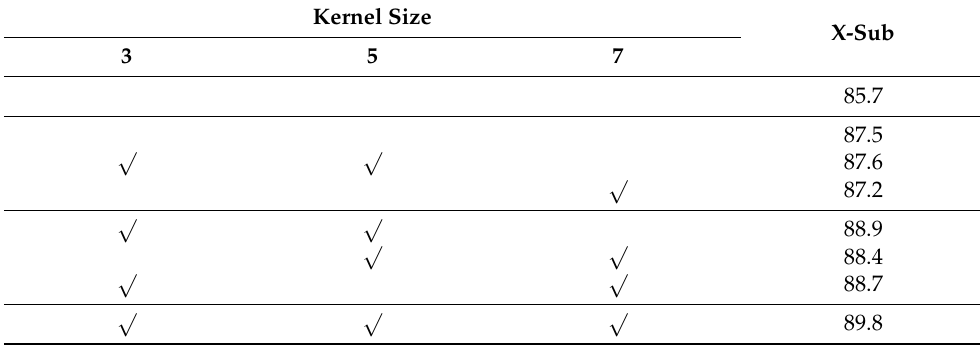
Table 5. Comparison of temporal convolution with different scales (%).